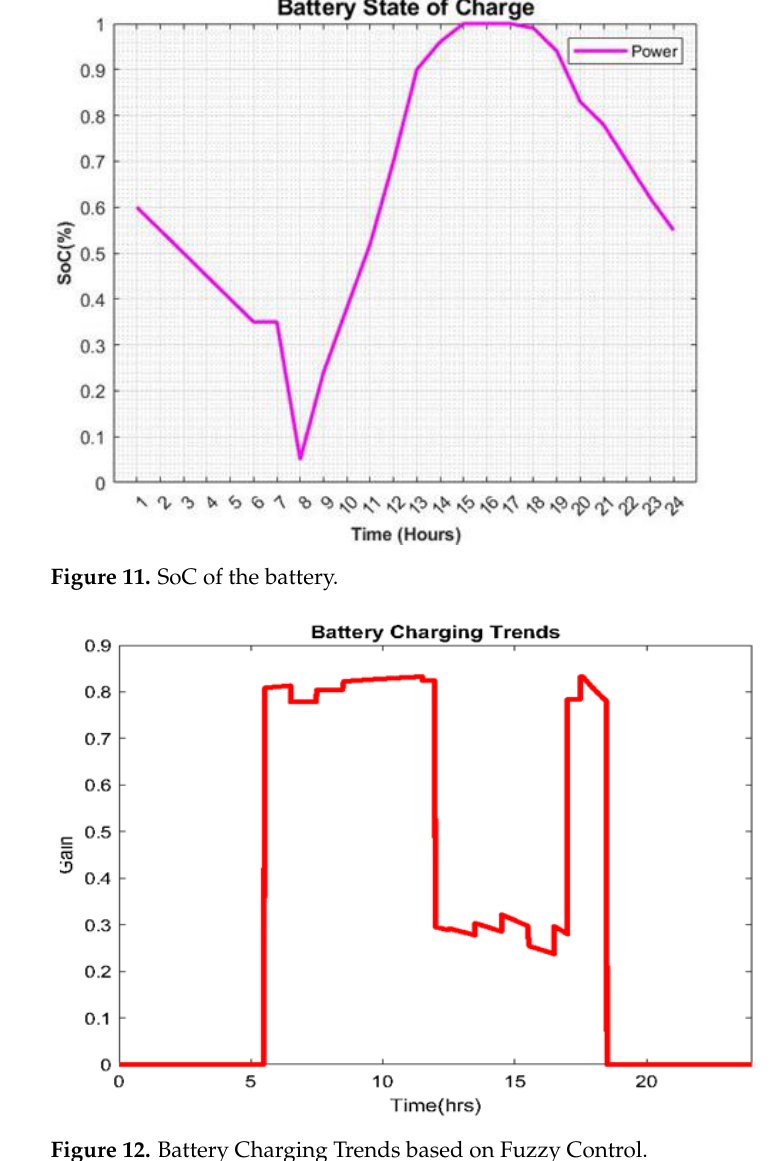
Figure 12. Battery Charging Trends based on Fuzzy Control.